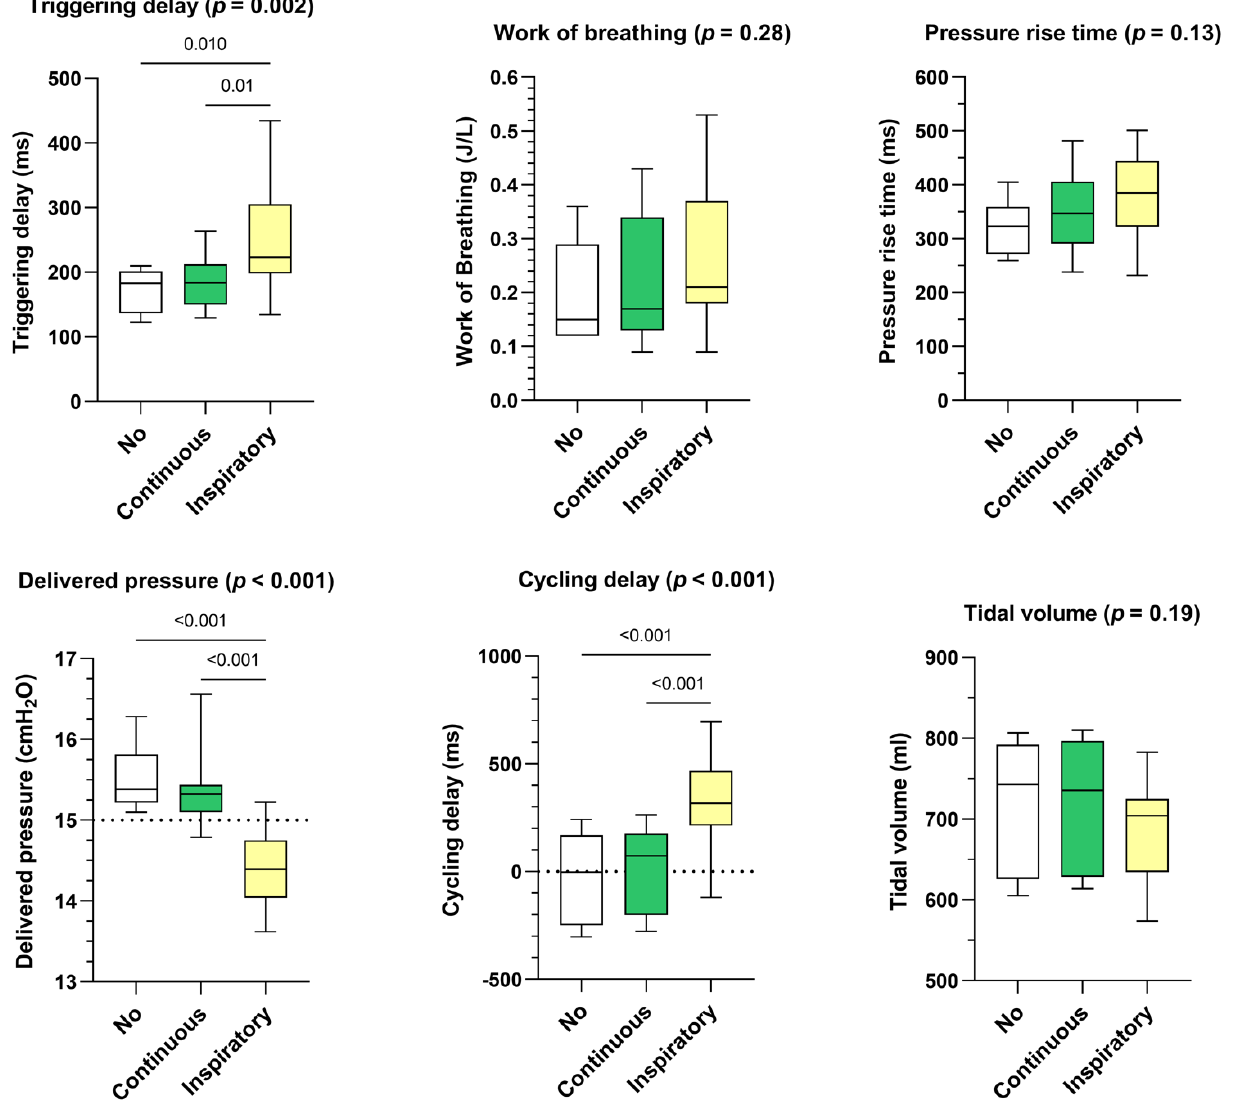
Figure 3. Consolidated data integrating the 3 respiratory models/devices without flow limitation according to the pattern of unintentional leak (continuous versus inspiratory) on triggering delays, work of breathing, pressure rise time, delivered pressure, cycling delay and tidal volume. Box plots «No» represent the control situation, i.e., without unintentional leakage.